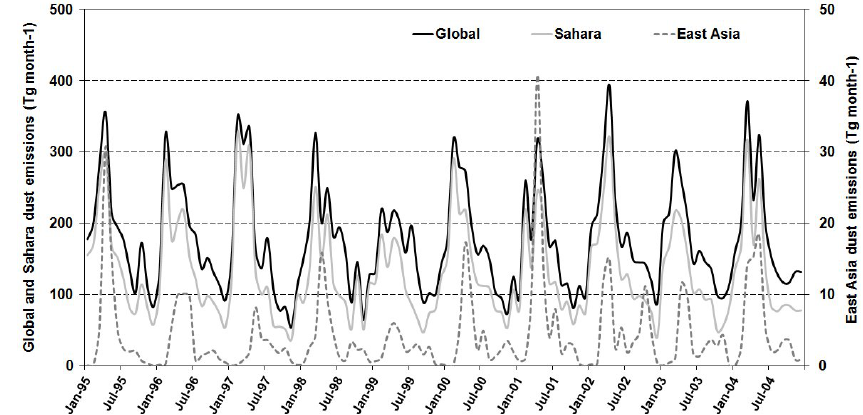
Fig. 4. Monthly emissions of mineral dust from global deserts and for the Sahara and East Asia desertic areas from 1995 through 2004.